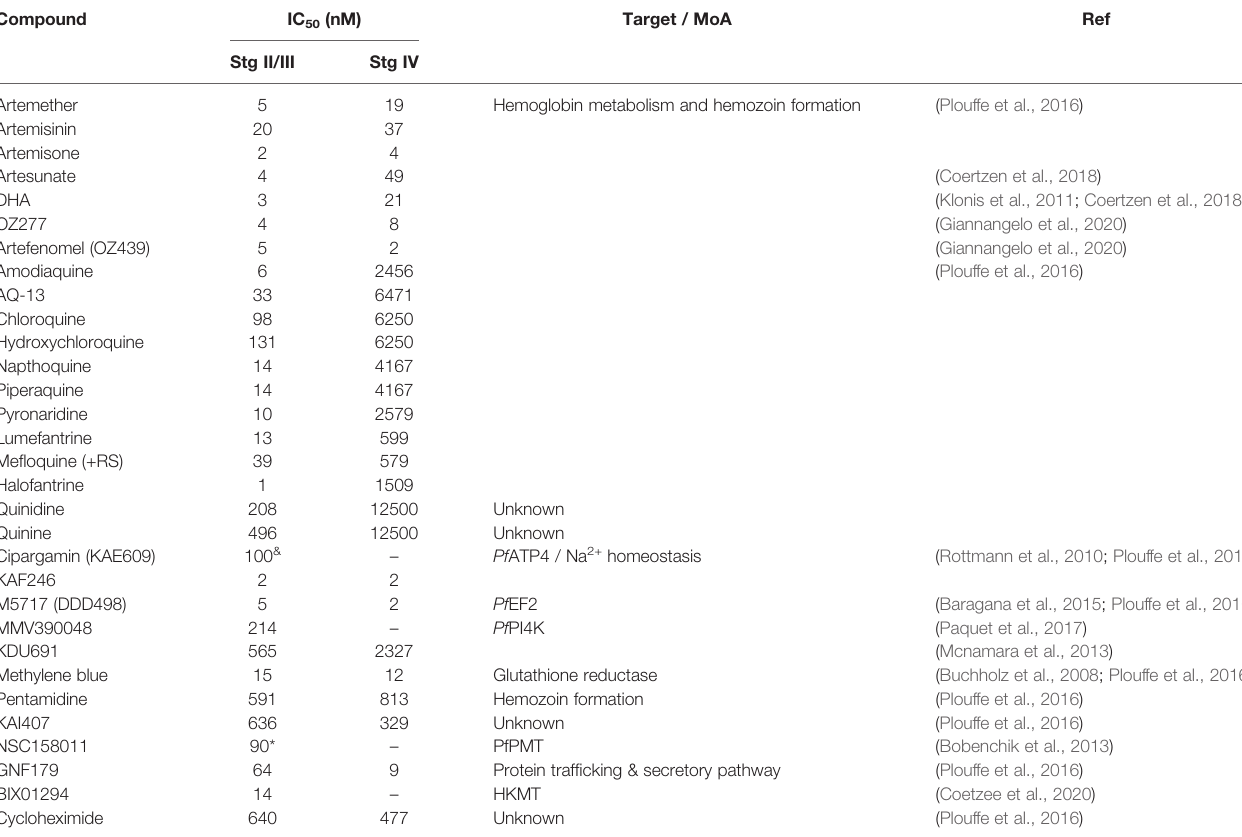
TABLE 1 | Summary of historical antimalarials, current front-runner and development compounds and novel hits with sub-micromolar in vitro activity against P. falciparum immature (stage II/III) gametocytes.